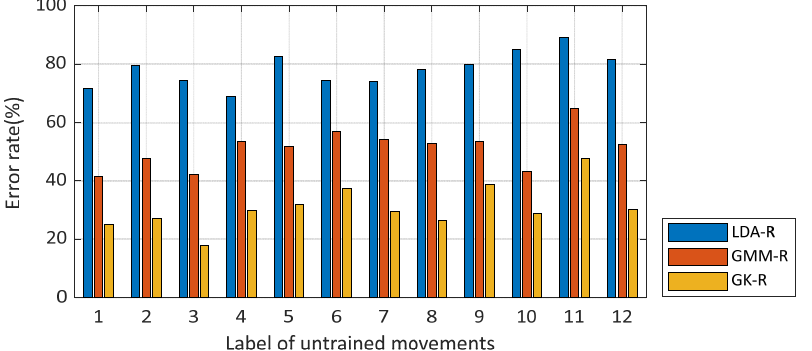
Figure 8. Classification performance on 12 untrained movements. The parameters of the classifiers are the same as in Figure 5. are the same as in Figure